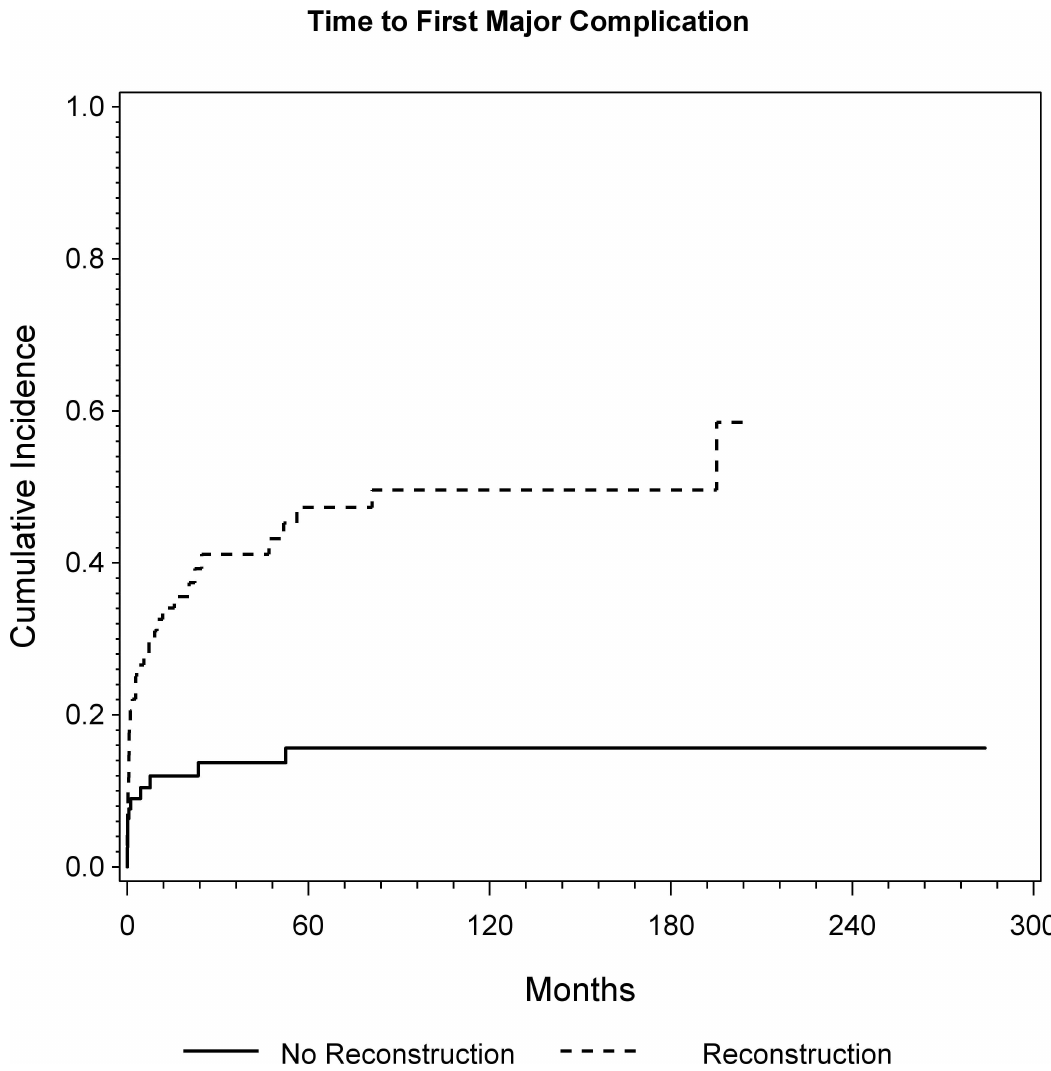
Fig 4. Cumulativeincidence of first major complication for patients with and without endoprosthetic reconstruction was assessedby CR analysis(p < 0.0001; HR =